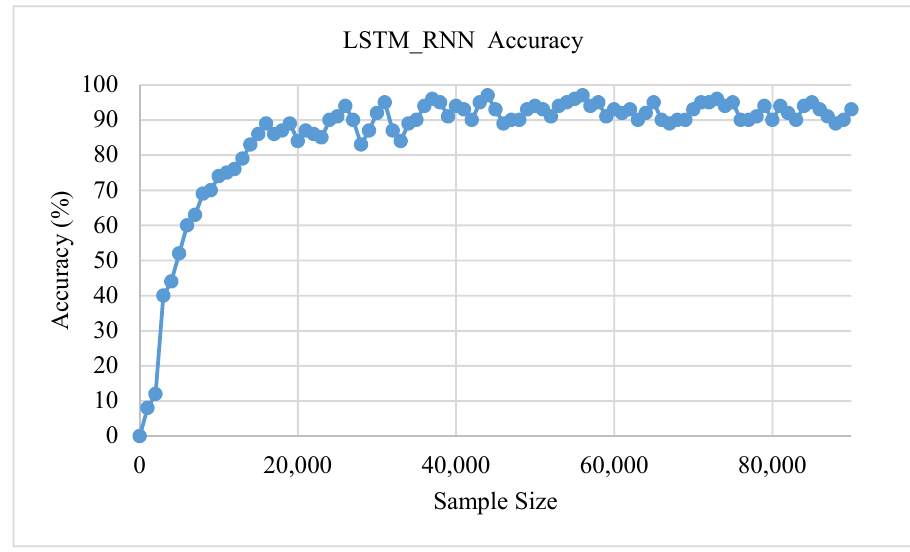
Figure 11. LSTM_RNN accuracy with the sample size.